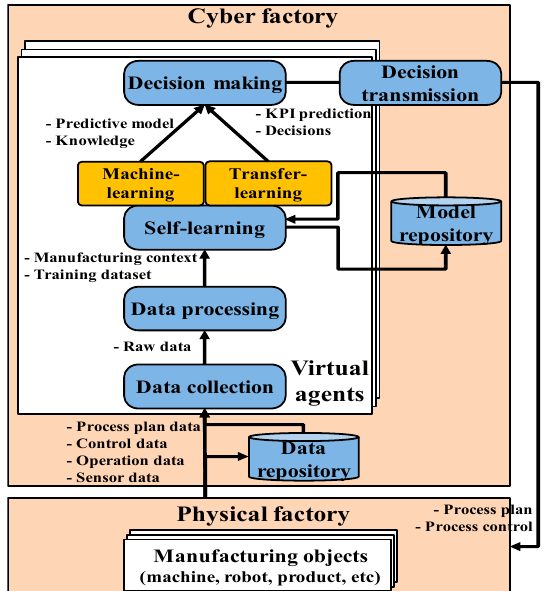
Figure 1. The concept of a self-learning factory. KPI: Key Performance Indicators.